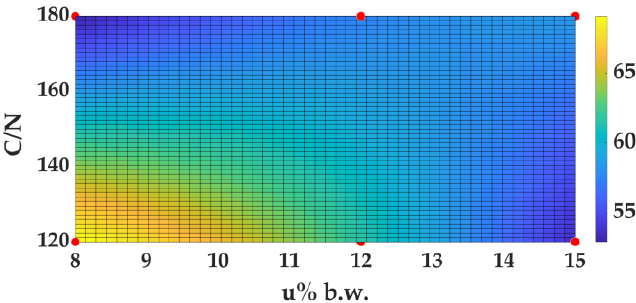
Figure 14. Response surface for diesel oil removal by microcosms with C / N = 120 and C / N = 180 at t = 71 days.